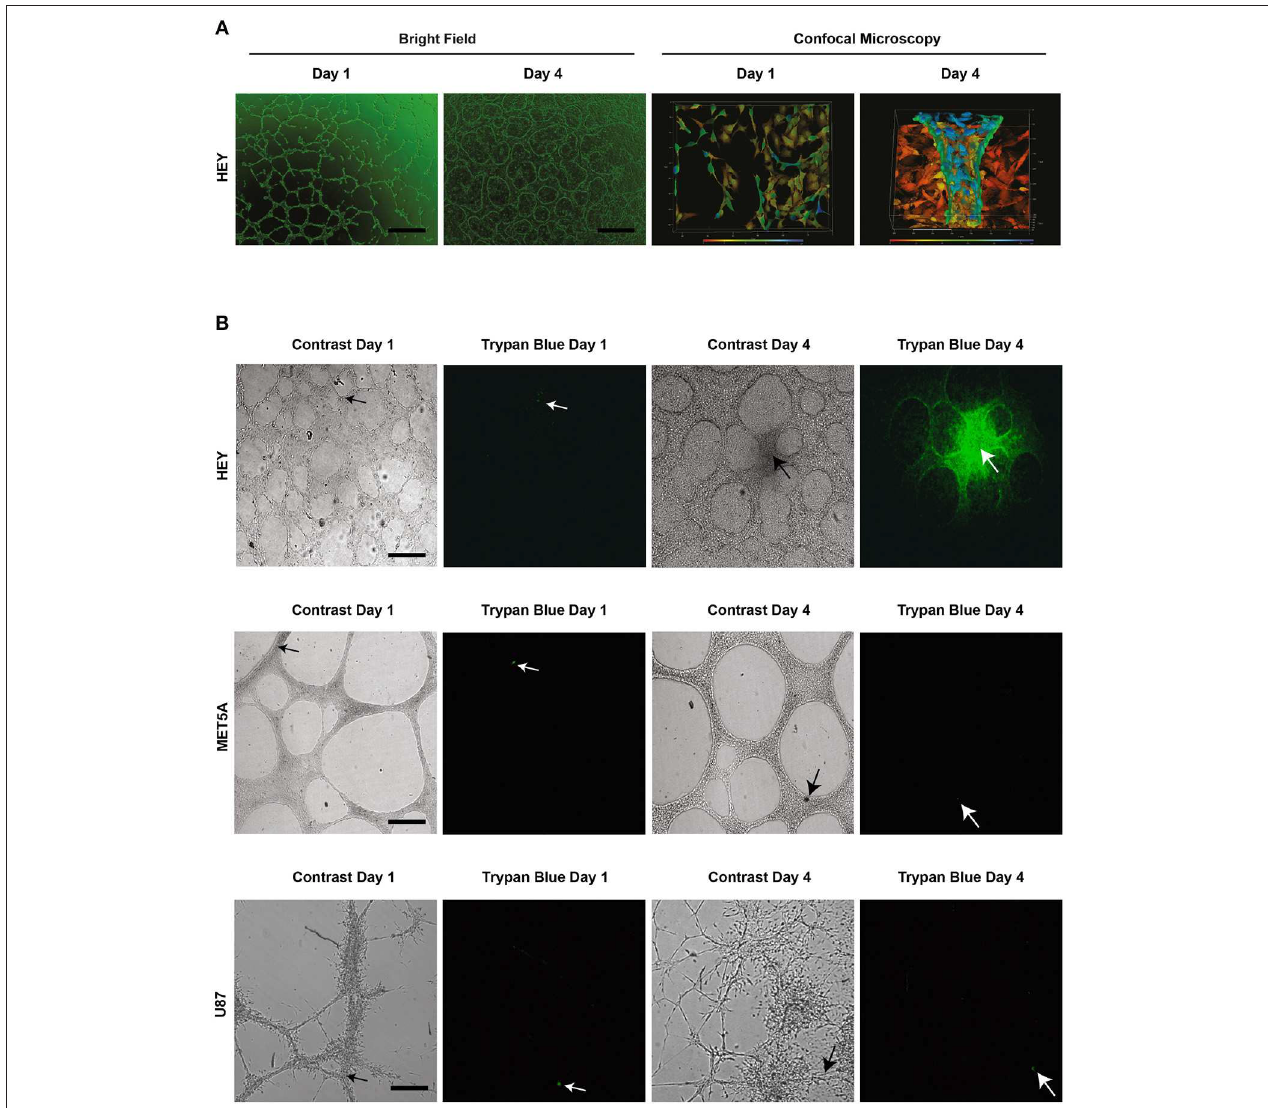
FIGURE 4 | Structures present in matrigel culture may not represent VM. The upper panel (A) demonstrates light (size bar represents 200 µ m) and confocal microscopy (size bar represents 500 µ m) images of day 1 and day 4 cell cultures of the HEY cancer cell line. The presence of a tubular hollow structure can clearly be seen at day 4 in culture. (B) demonstrates dye microinjections of the HEY cell lines at day 1 and 4, showing movement of fluid and thus functional tubes (upper panel). Despite the formation of what is often reported in the literature to refer to tubular structures (VM), no movement of dye was observed in the MET5A or the U87 cell lines at day 1 and 4 (middle and lower panel respectably). In fact, the dye either remained in an individual cell or dispersed from culture. Arrow heads display injection sites, all size bars represent 250 µ